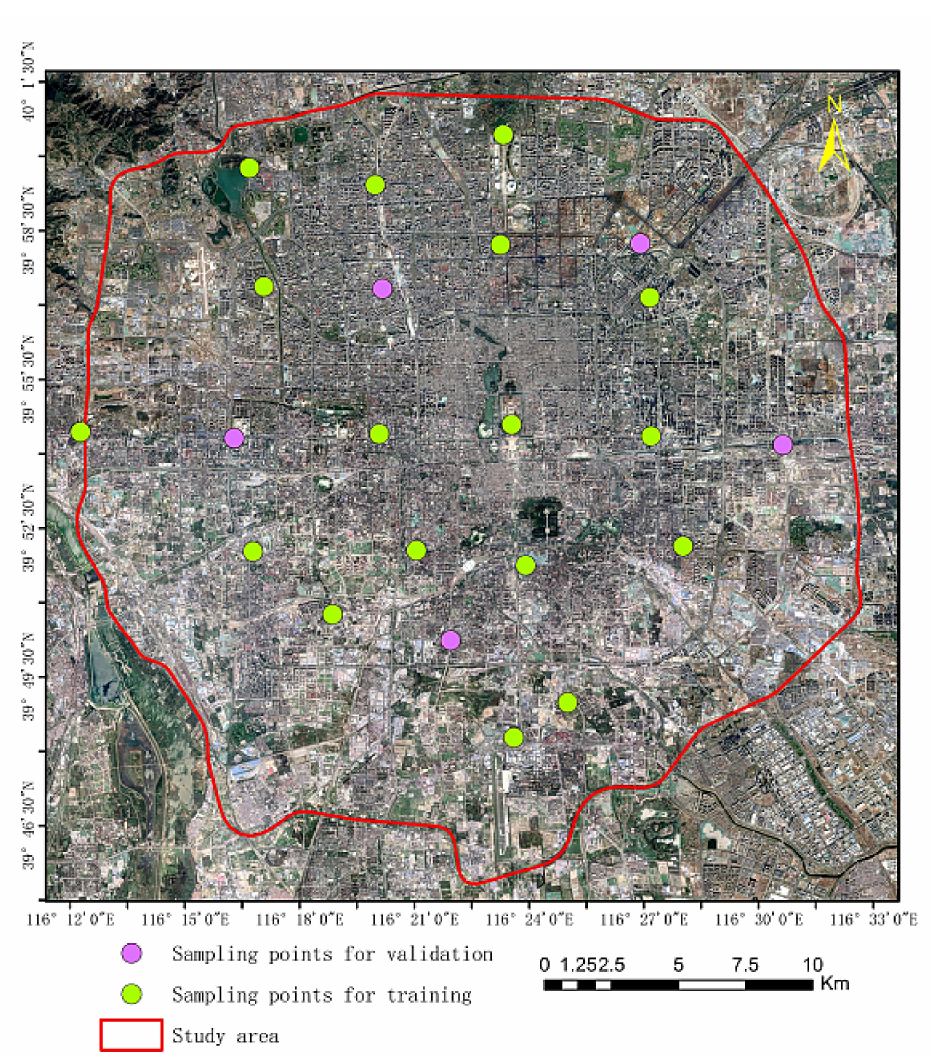
Figure 2. The study area and sampling points in this article. The image data is L14-level data obtained from Google